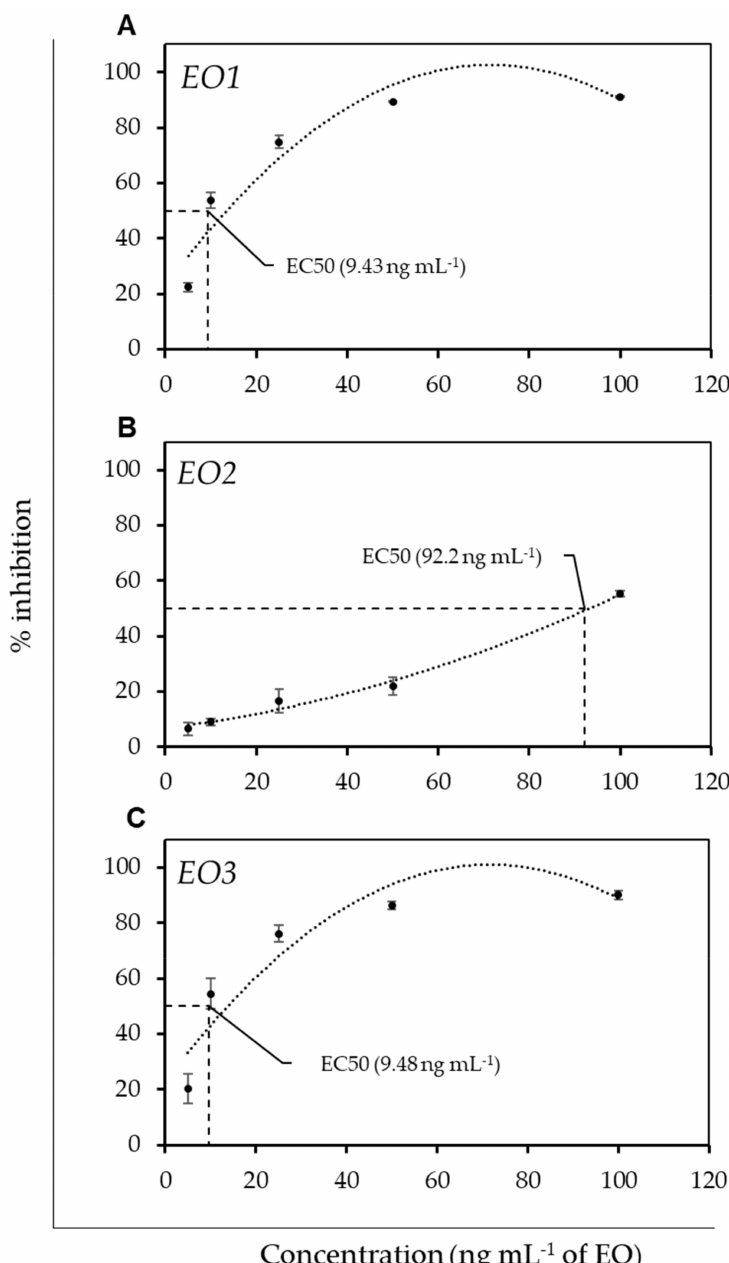
Figure 5. Comparison of antioxidant activity of essential oil from O. gratissimum (EO1, ( A )), O. tenuiflorum (EO2, ( B )), and O. sanctum (EO3, ( C )) via DPPH radical scavenging